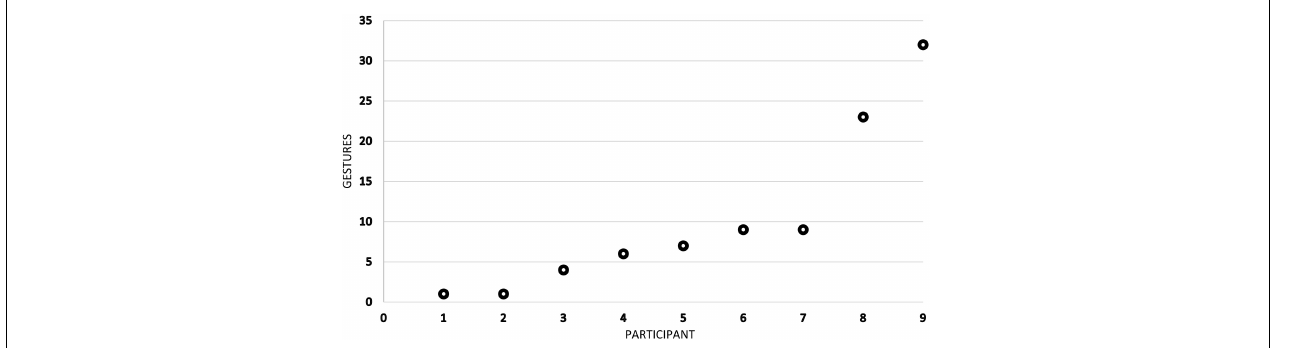
FIGURE 1 | Frequency distribution of action-depicting gestures in the data (individual values sorted from smallest to largest). Mean = 10.22, SD = 10.47, n = 9.